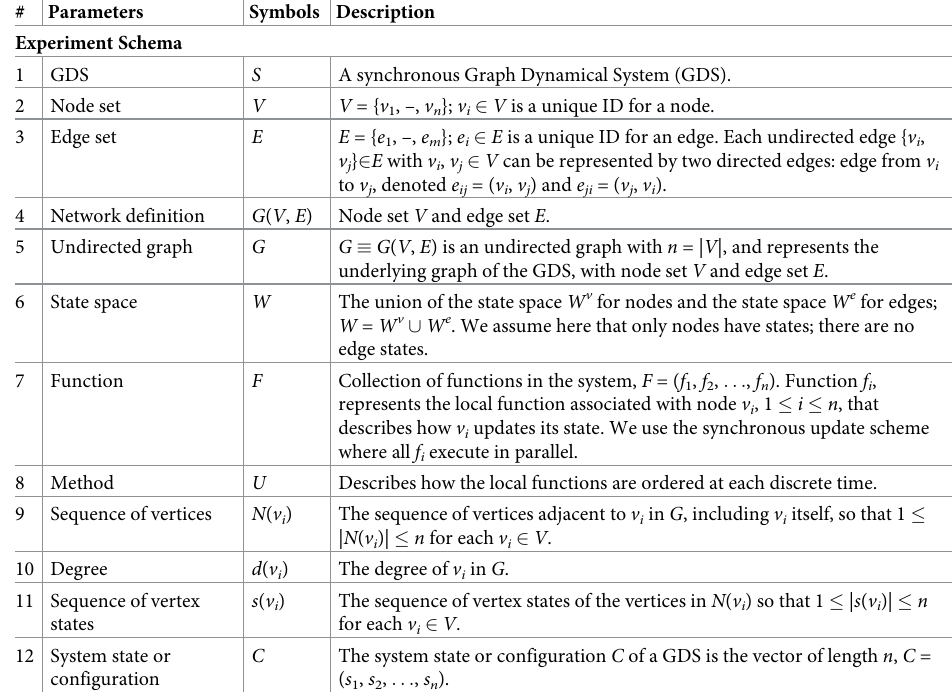
Table 4. Symbols used to describe our computational model known as a discrete Graph Dynamical System (GDS). # Parameters Symbols